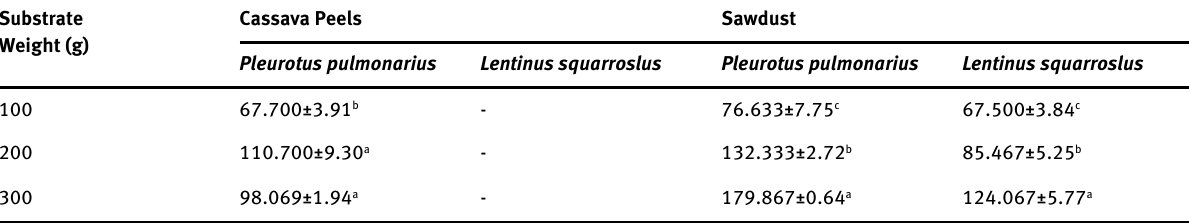
Table 3: Fruiting pattern of Cassava Peels Spawn supplemented with Rice bran of Pleurotus pulmonarius and Lentinus squarroslus on Cassava peels and Sawdust